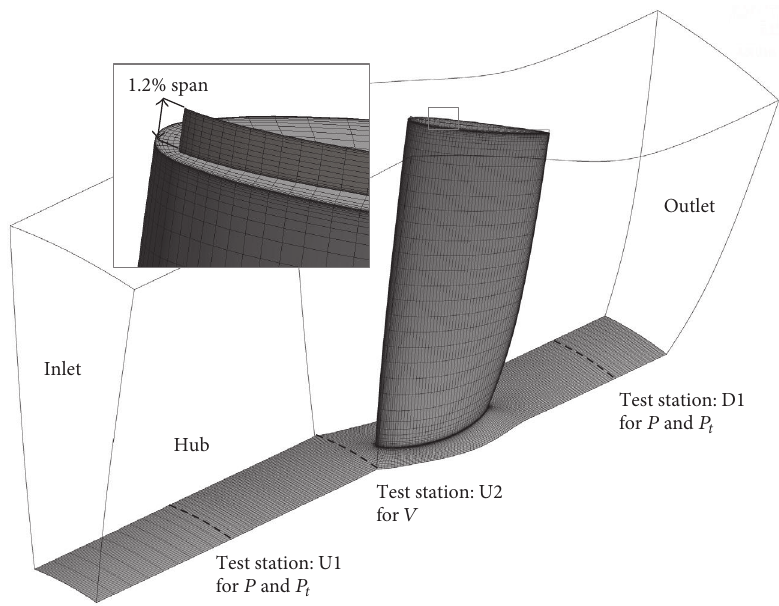
Figure 1: The computational grid developed for the rotor model.